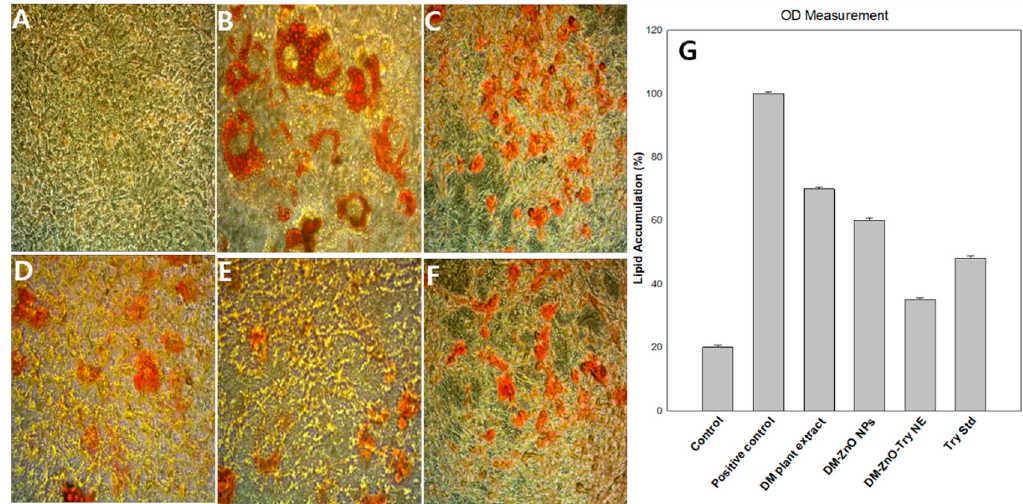
Figure 10. Cell differentiation of ( A ) control, ( B ) positive control, ( C ) DM extract, ( D ) DM-ZnO-NPs, ( E ) DM-ZnO-Try–NE, and ( F ) tryptophan at 10 μ g/mL and at 20× magnification ( G ) OD measurements for lipid accumulation.